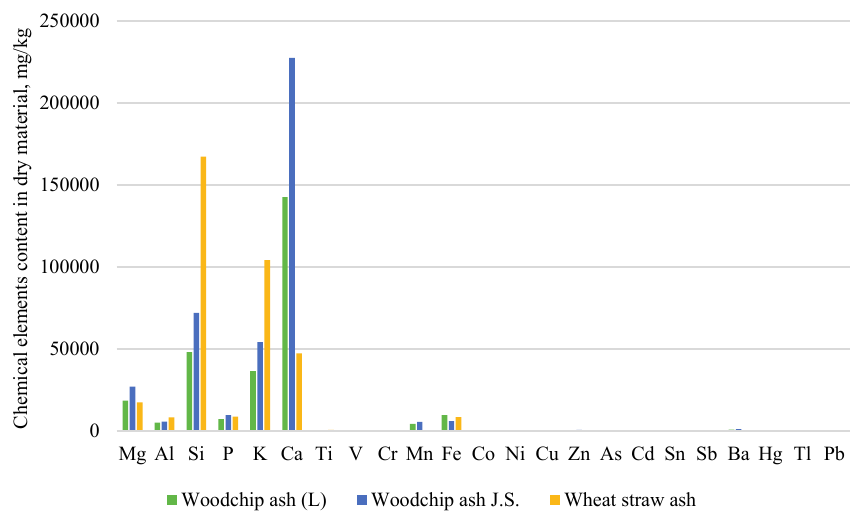
Fig. 3. Chemical elements content in the dry material of woodchip and straw ash